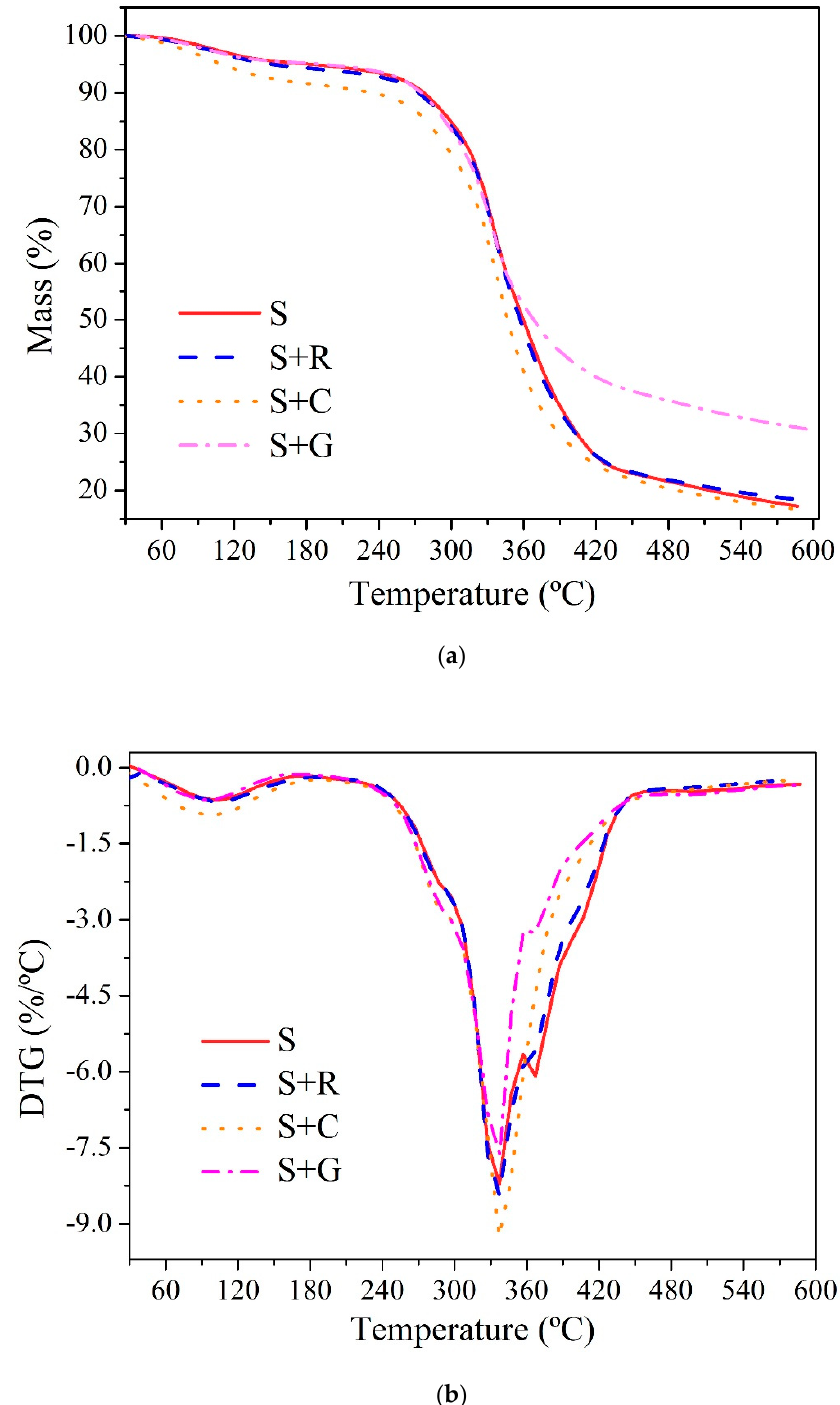
Figure 6. Thermal analysis typical curves for the hybrid composites: ( a ) TG and ( b ) DTG.